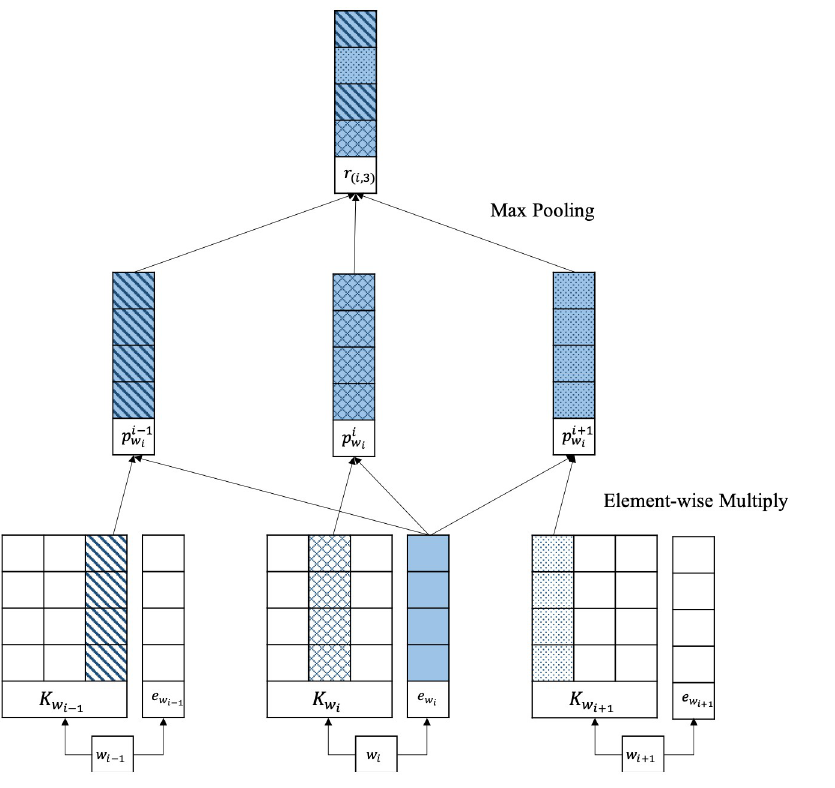
Fig 1. Context-word region embedding